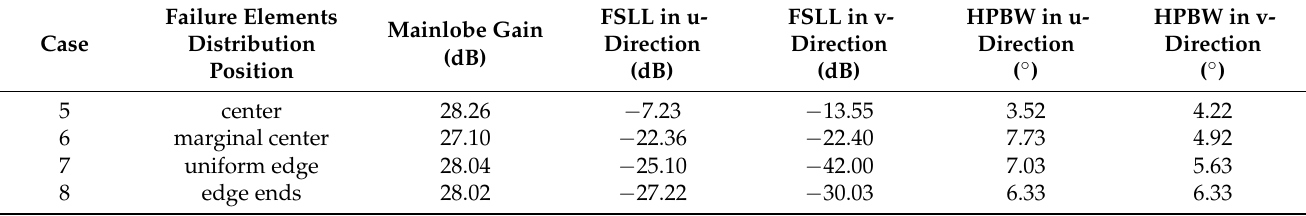
Table 9. Electrical performance parameters in the receiving mode in different failure elements distribution